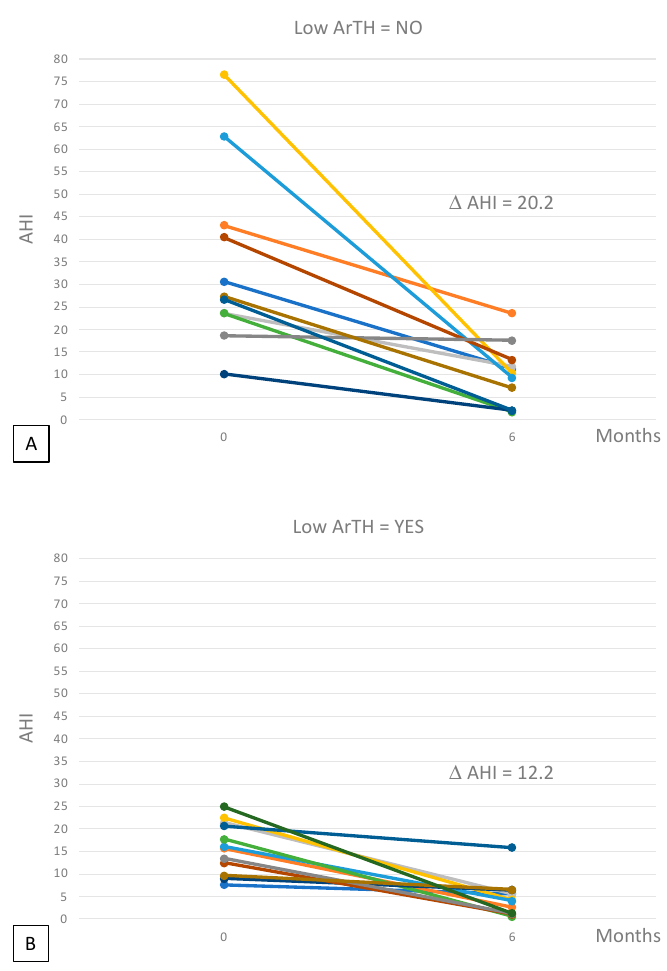
Figure 3. Spaghetti plots reporting the individual data (different color for each patients) of the variation of AHI among patients without low ArTH (panel A ) and with low ArTH (panel B ). D AHI was 20.2 vs. 12.2, respectively; p = 0.03.